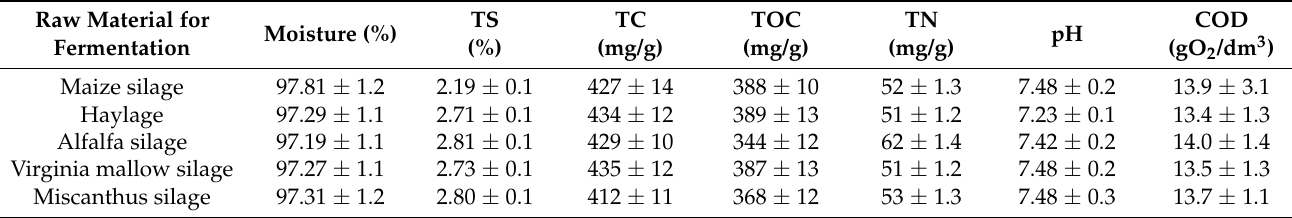
Table 3. Characteristics of the anaerobic sludge–plant feedstock